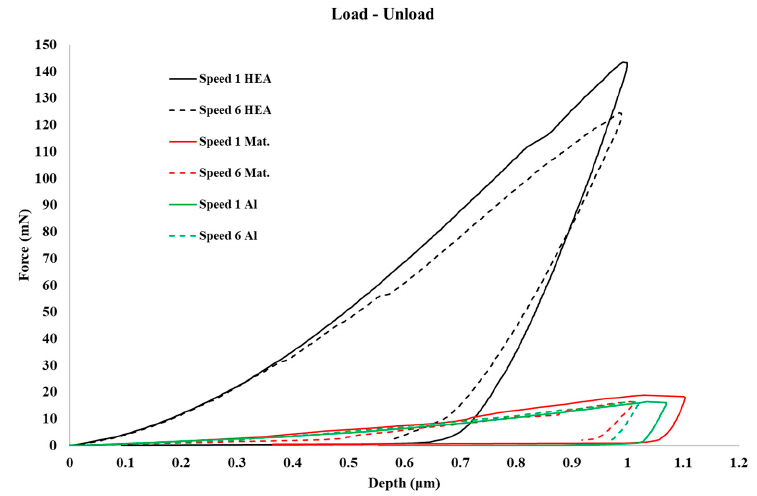
Figure 1. Nanoindentation load—unload cycle curves for pure Al, matrix, and HEA reinforcement. Tables 1 and 2 (speed 1 and speed 6 respectively) shows the values obtained from nanoindentation testing for the standard mechanical properties, i.e., E it the modulus of elasticity by nanoindentation, n it the absorbed energy in the elastic region versus the over- all absorbed energy and the hardness of the material HV. Table 1. Nanoindentation based fundamental mechanical properties (loading speed 1).